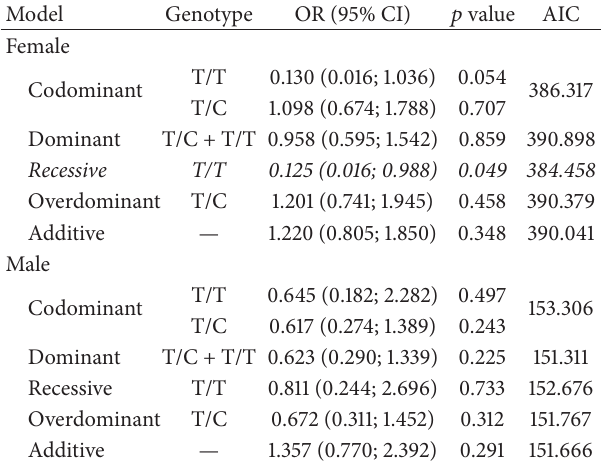
Table 6: Binomial logistic regression analysis of the CYP4F2 (1347C > T; V433M) rs2108622 in the patients with early AMD and in the control group.